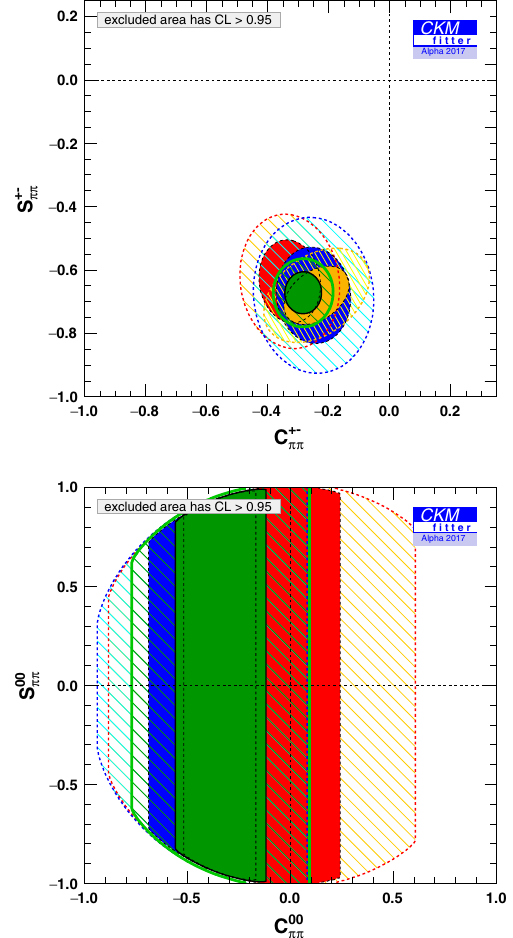
Fig. 43 Measurements of the B → ππ CP asymmetries from BaBar ( blue curve ) and Belle ( red curve ). When available, other experimental contributions are shown: LHCb ( orange ), CDF ( purple ) and CLEO ( black ). The green shaded area represents the world